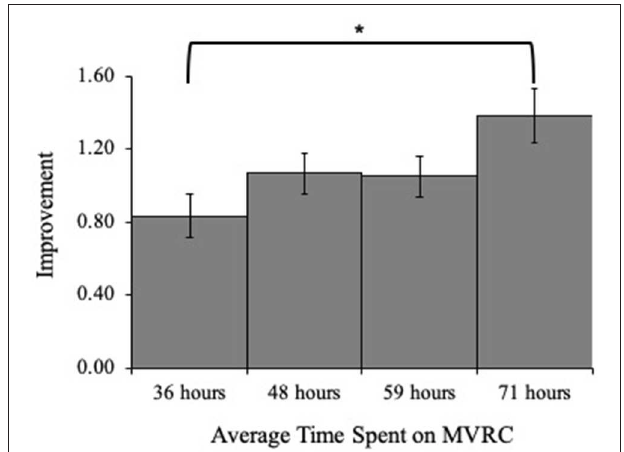
FIGURE 1 | Average improvement of 2nd-grade reading fluency, as a function of hours practiced (separated into quartiles). Error bars represent standard errors. *Significant difference obtained with Bonferroni pair-wise comparisons ( p < 0.05).